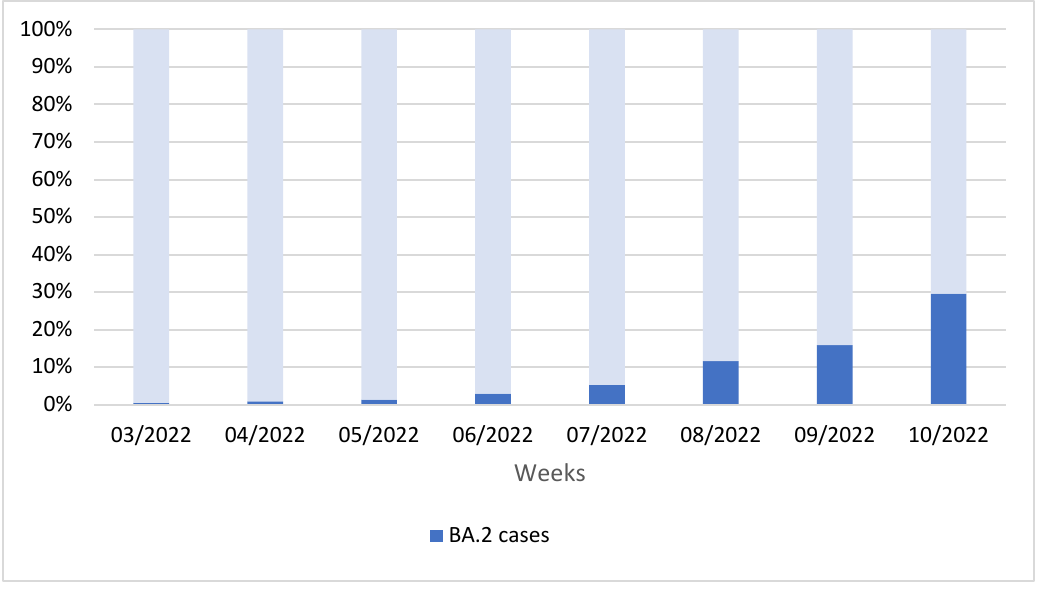
Figure 1. Distribution (%) of Omicron BA.2 cases among new SARS-CoV-2 infections identified from week 3 to week 10 of 2022 in the Apulia region of Italy.